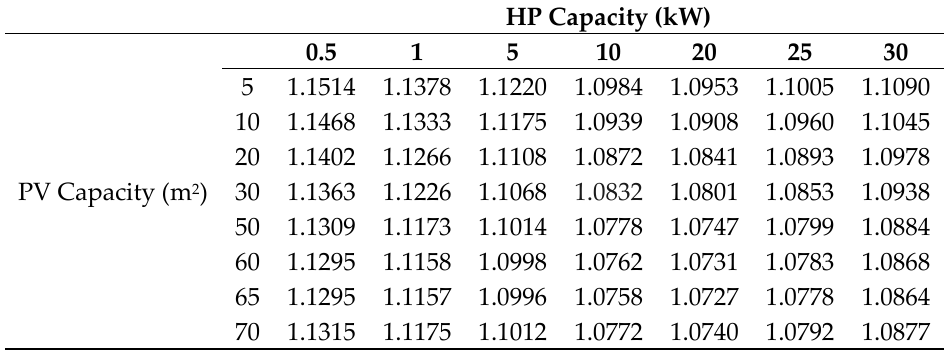
Table 4. Annual Cost for single building under Different PV and HP capacity (×10 4 Euro/year).